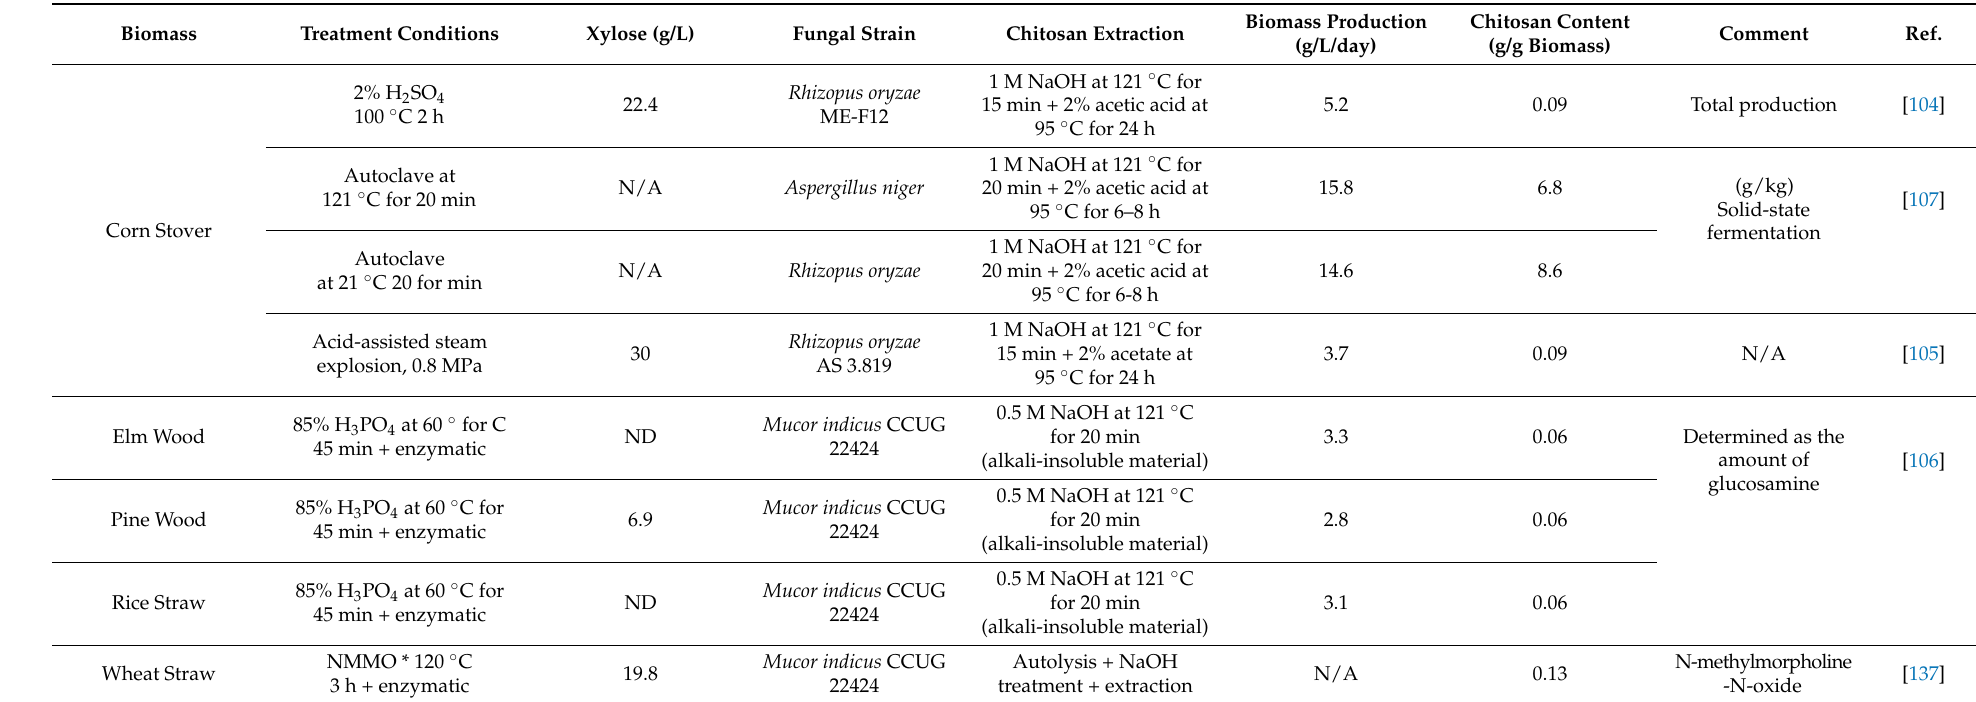
Table 7. Review of production methods for fungal chitosan from